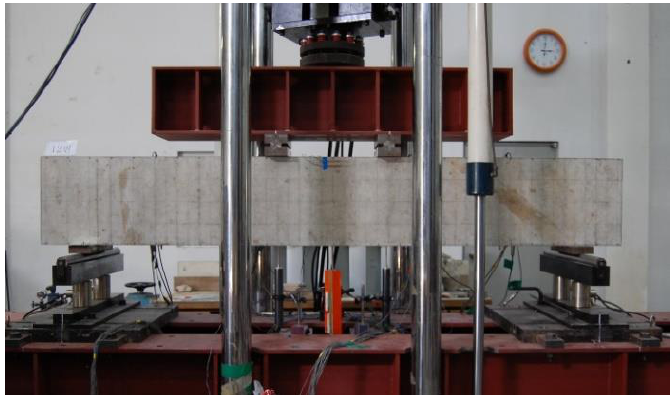
Figure 4. View of test setup of a specimen tested in the previous study [8,9].